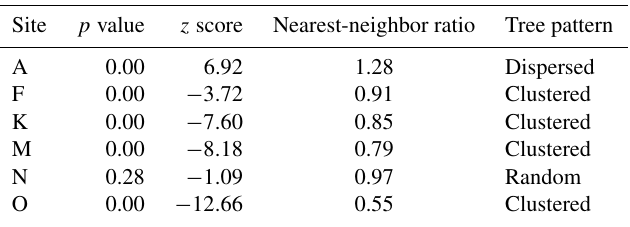
Table A2. Average nearest-neighbor results for each site. The null hypothesis here is that trees are randomly distributed. The nearest-neighbor ratio is the mean of observed mean distance over the expected mean distance between neighbors assuming a random distribution. The ratio equal or close to 1 is considered random. Only site N has a random distribution pattern of trees. As site A contains a dense canopy and several trees far from it, the method takes it as dispersed.